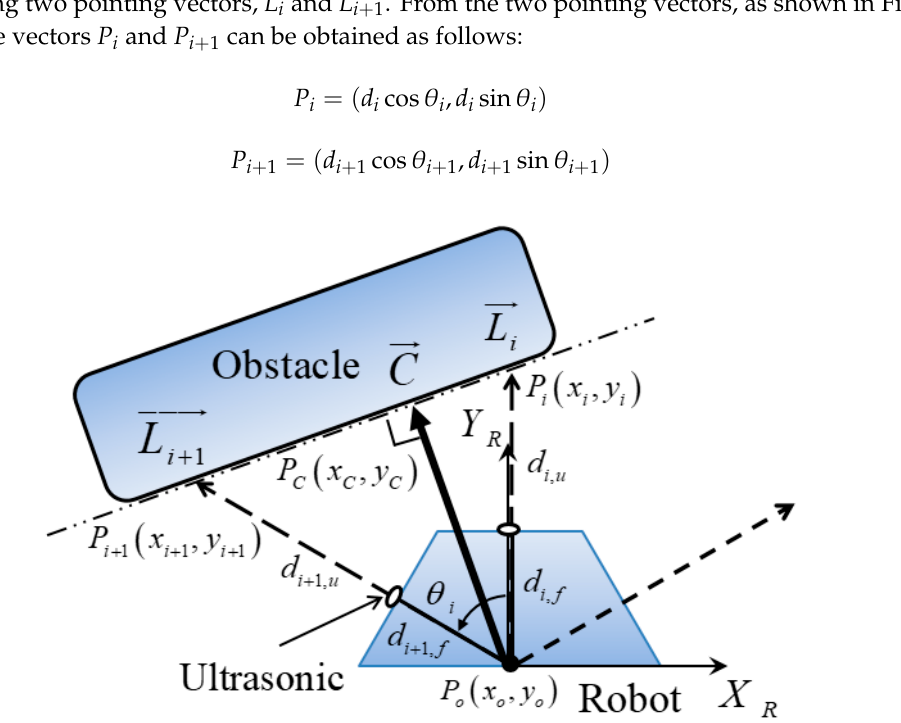
Figure 3. Diagram of the collision vectors.